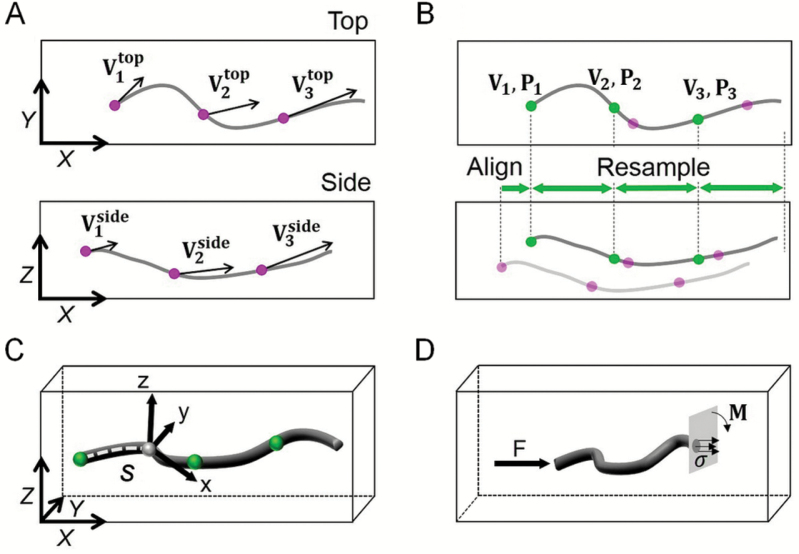
Image processing pipeline for 3D mapping of mechanical stress and elongation rate in root. (A) Top and side images of the root were analysed using particle image velocimetry. (B) Both velocity and coordinates, (respectively V and P were aligned in the direction of growth (X axis) and resampled using interpolation functions. (C) A local coordinate system was used to project full 3D velocity and coordinates in a reference coordinate system. (D) Beam theory was then used to compute stresses in the root from the force measured using the sensor.